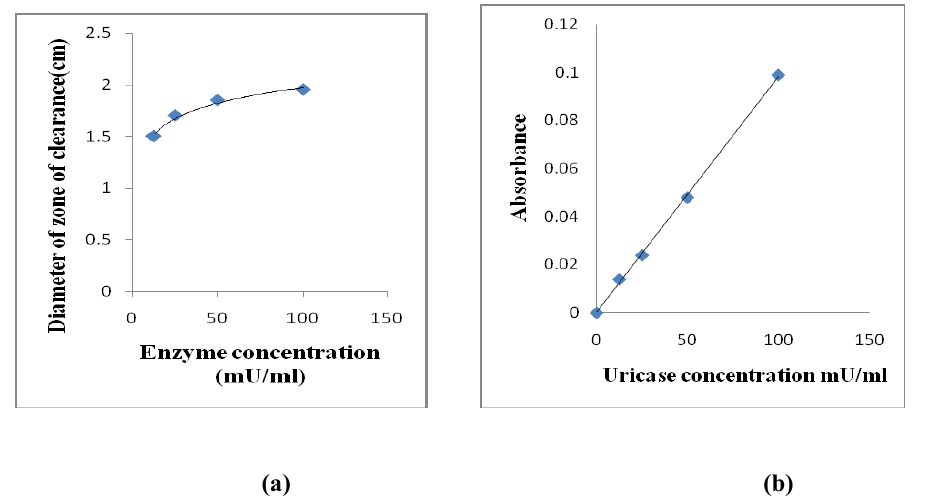
Figure 3. (a) Graph indicating the relationship between the enzyme concentration and (a) diameter of the zone of clearance developed, (b) optical absorbance at 560 nm wavelength of light.